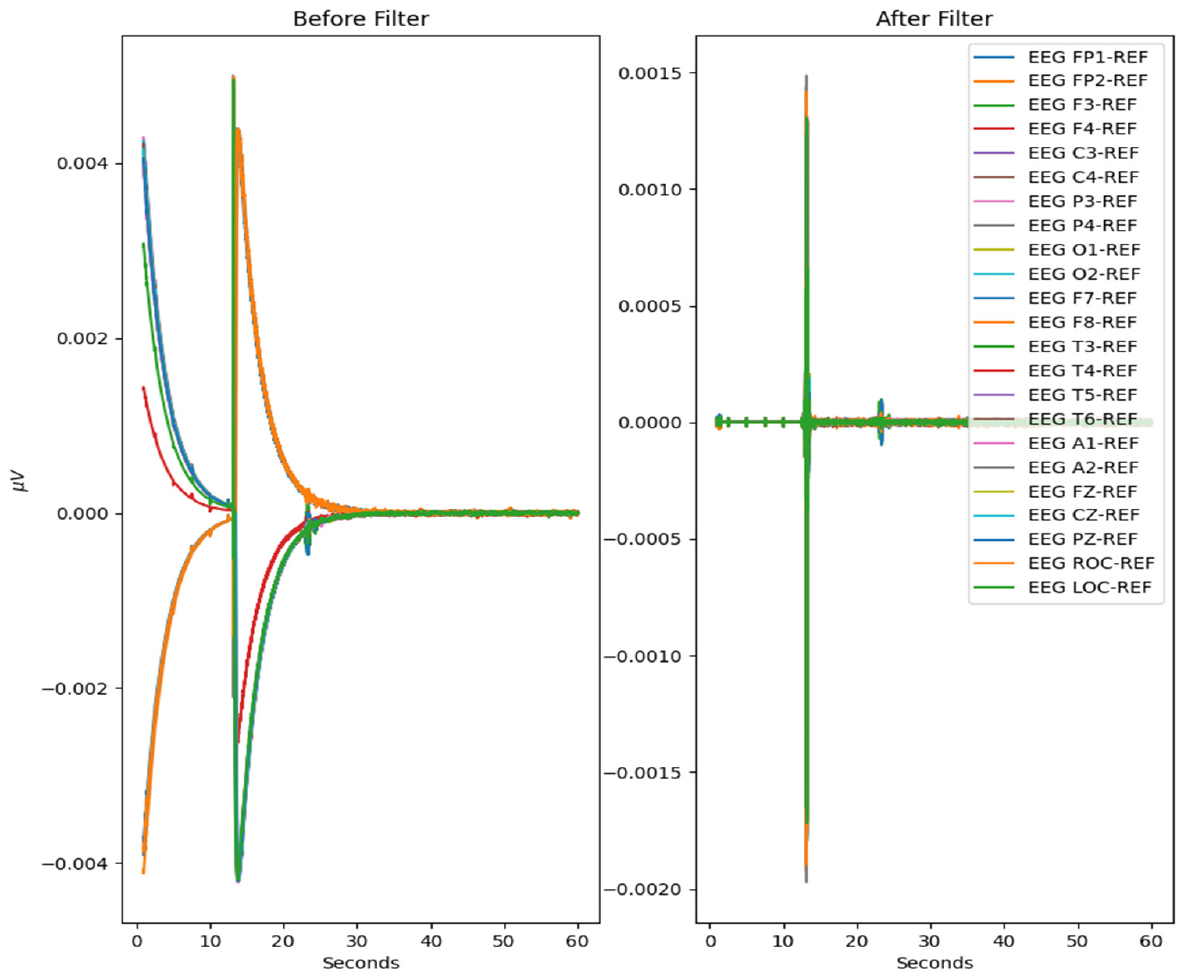
Figure 9. Difference in extraction of various frequency bands.